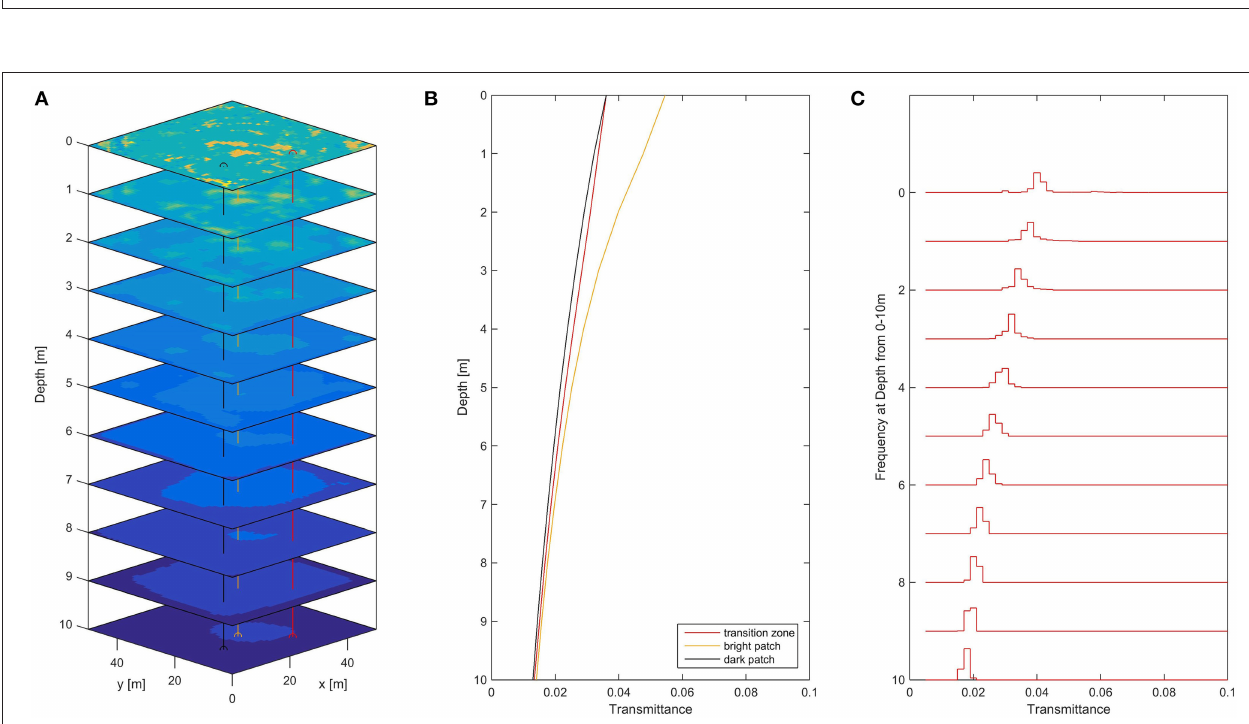
FIGURE 9 | (A) Depth slices of the light field underneath a real surface geometry extracted from an aerial image. Transmittance values are obtained from a simplistic radiative transfer model. Bright colors show high light transmittance. (B) Vertical irradiance profiles extracted at three different close lying locations indicated in (A) . (C) Probability distributions of the under-ice light field as measured in depths from 0 to 10 m.